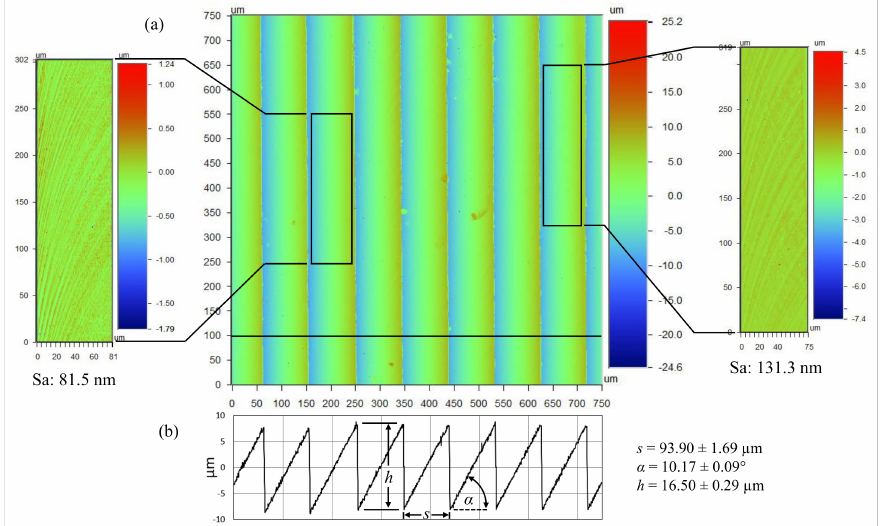
Figure 10. Surface topography of h = 16 µ m ATR sample: ( a ) areal surface roughness of the conven- tionally ( left ) and climb ( right ) milled primary facets and ( b ) ATR form geometry. The areal surface roughness ( S a ) was measured at several locations of the primary facets in order to determine the average roughness of climb and conventional